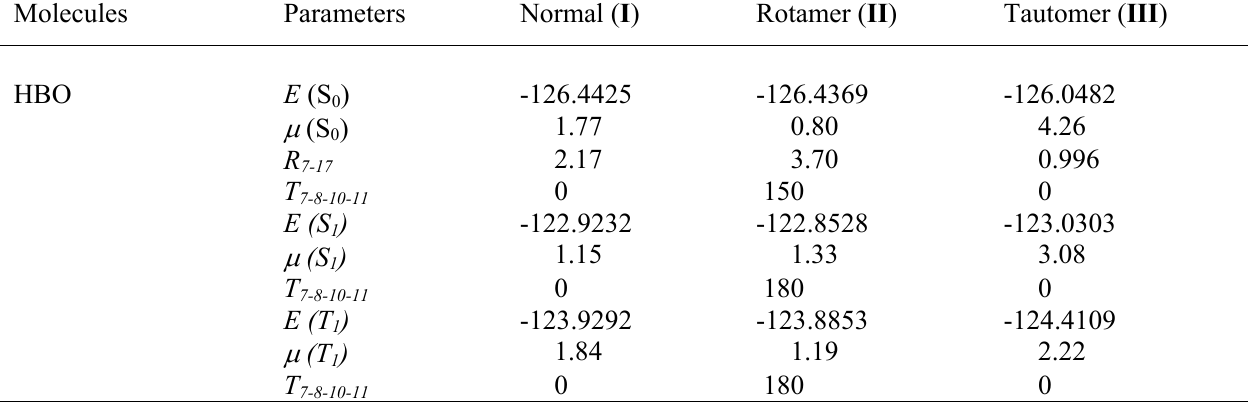
Table 2. Equilibrium parameters of different photoisomers of HBO, HBI, HBT and HPO, HPI, HPT represents the interatomic distance between the two atoms for the in different electronic states. R 7-17 first series and R represents it for the other series referred to by the numbers (see Scheme 1). T 8-13 is the torsional angle developed by the atoms of the first series and T 11 of the second